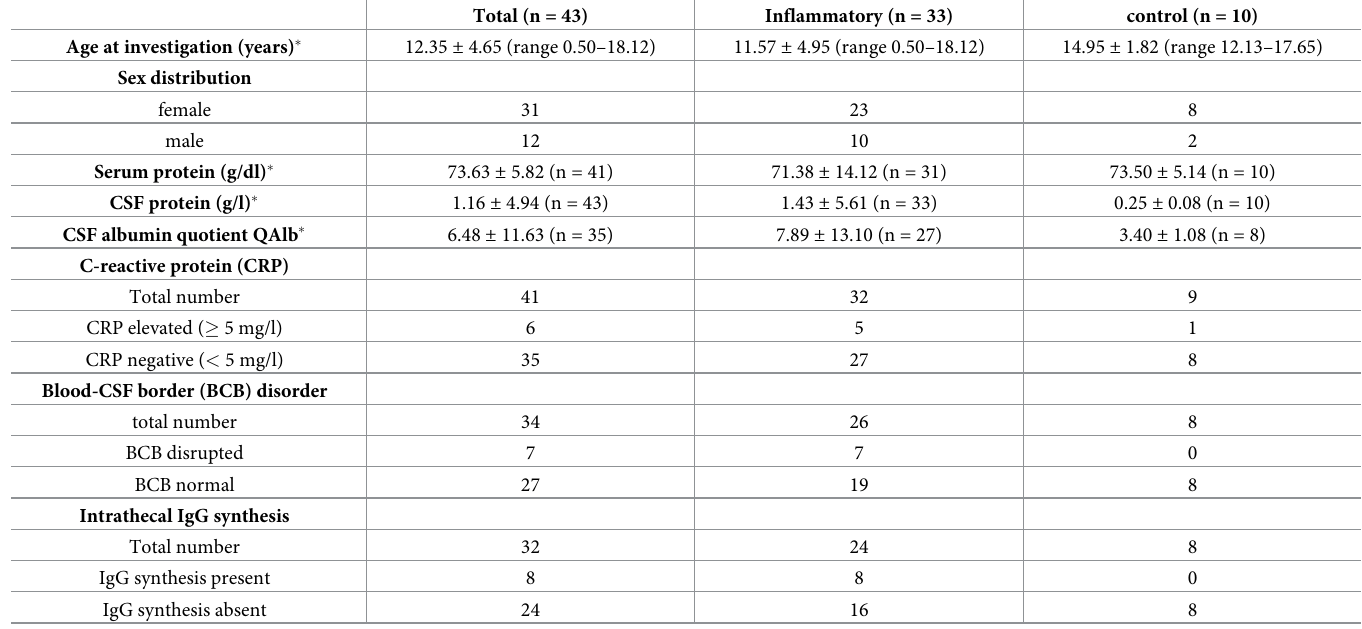
Table 5. Clinical data of samples for phosphorylation studies.